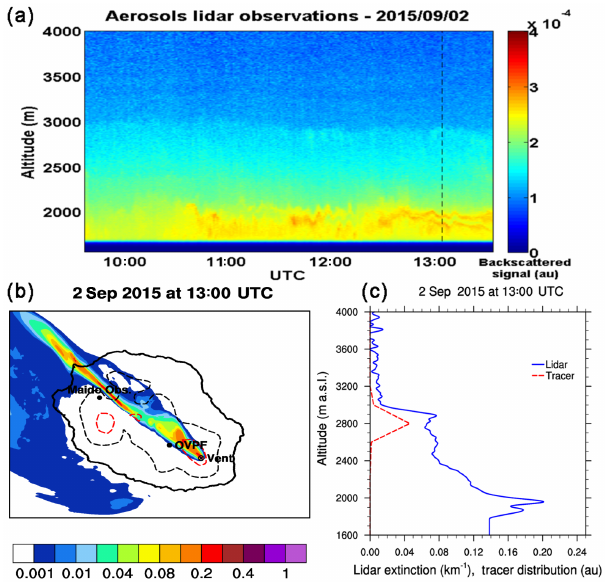
Figure 10. (a) Time series of the backscattered signal (arbitrary unit) and profile (black dashed line) located at the OVPF site on 2 September 2015 and used to retrieve the extinction profile shown in the bottom right panel. (b) FLEXPART simulation of the vol- canic tracer load modelled on 2 September 2015 at 13:00UTC and location of the pick-up truck (OVPF). (c) Aerosol extinction profile retrieved on 2 September 2015 at 13:10UTC (blue line) and tracer profile simulated by FLEXPART at the same location at 13:00UTC (dashed red line).